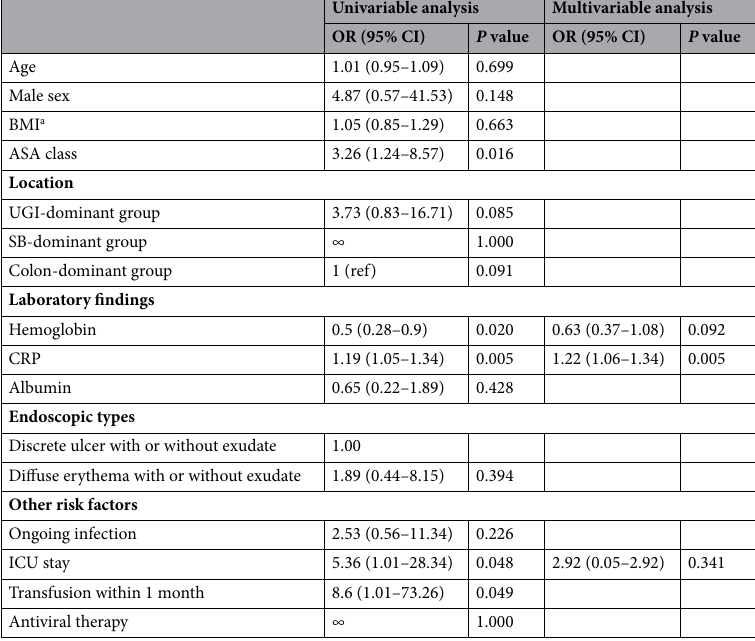
Table 4. Risk factors for in-hospital mortality in immunocompetent patients with cytomegalovirus gastroenterocolitis. OR, odds ratio; CI, confidence interval; BMI, body mass index; ASA, American Society of Anesthesiologists; UGI, upper gastrointestinal tract; SB, small bowel; CRP, C-reactive protein; ICU, intensive care unit. a BMI data were not available for 2 of the 86